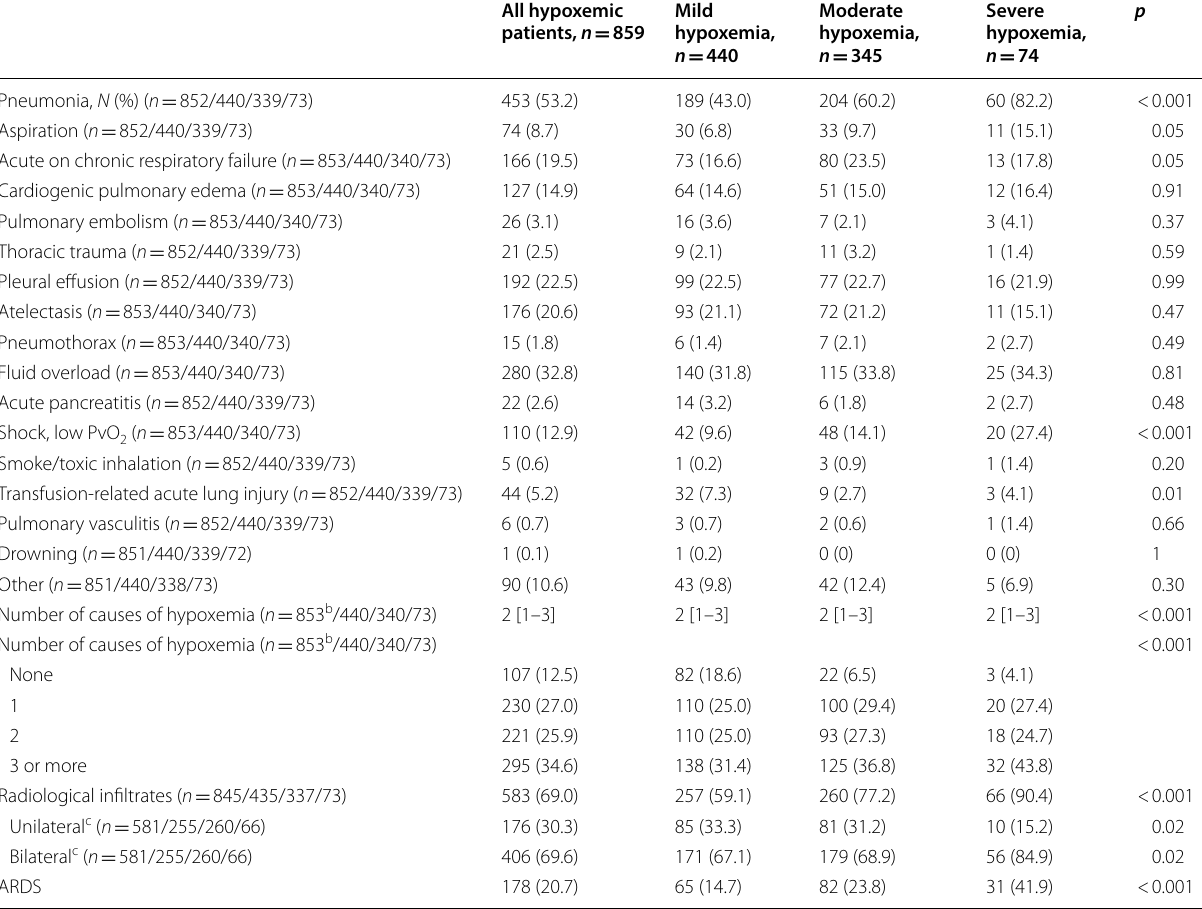
Table 2 Mechanisms/causes of hypoxemia a and radiological findings according to severity of hypoxemia on the day of the